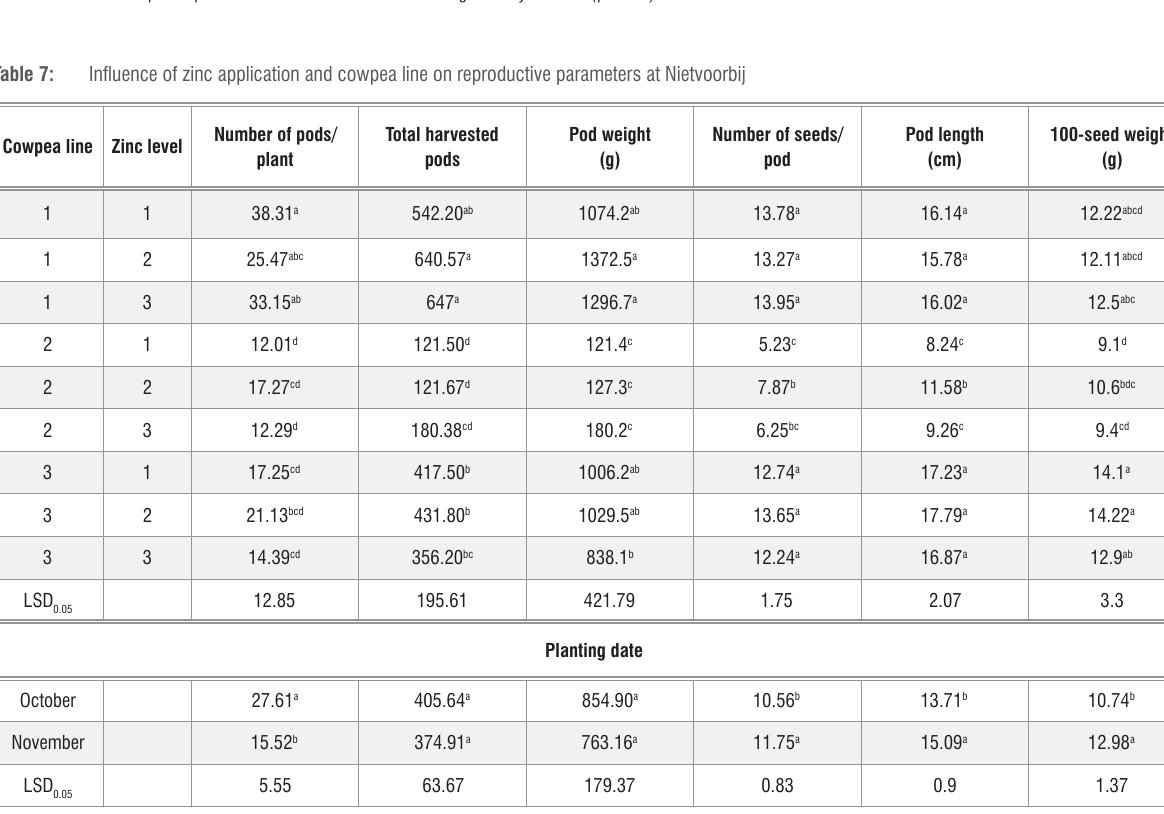
Table 7: Influence of zinc application and cowpea line on reproductive parameters at Nietvoorbij